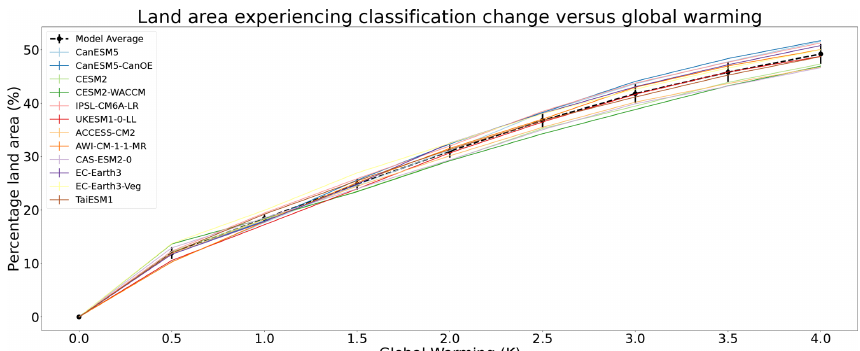
Figure 6. The percentage of land area projected to see a change in bioclimate as a function of global warming, using the traditional Köppen– Geiger classification with anomaly correction. Note the robust agreement between models, which implies a multi-model ensemble mean change which is well approximated by f = 1 − e − 0 . 14 (cid:49)T .